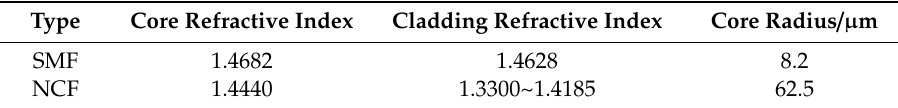
Table 1. Optical fiber’s